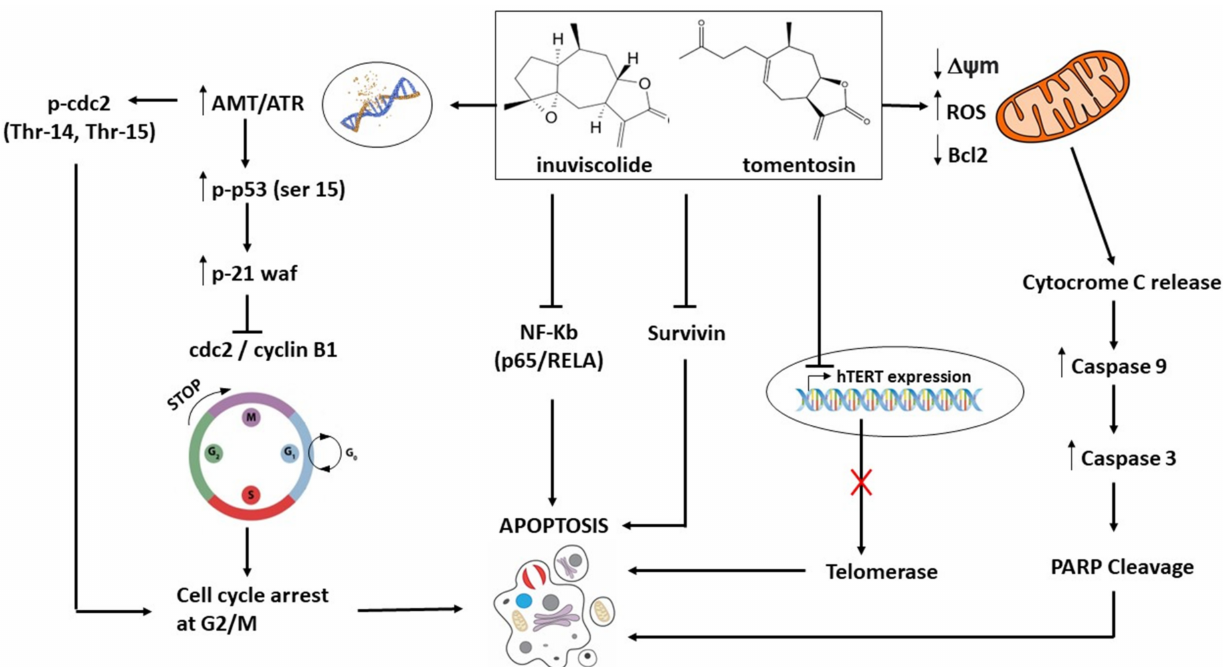
Figure 1. Molecular mechanisms of apoptosis induced by tomentosin and inuviscolide in neoplastic